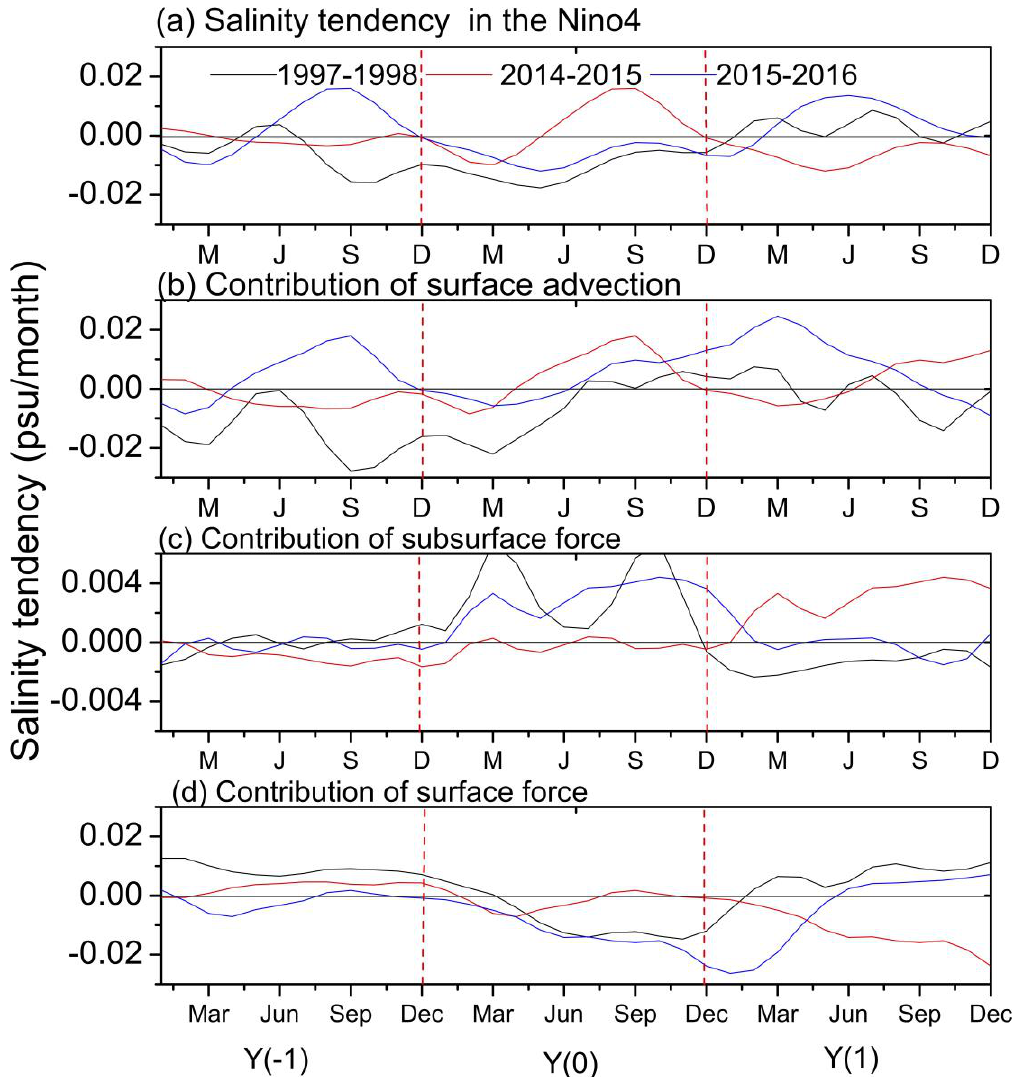
Figure 7. Contribution of MLS budget terms for ENs in 1997–1998 (black), 2014–2015 (red) and 2015–2016 (blue) for ( a ) salinity tendency, and salinity budget terms, ( b ) surface advection, ( c ) subsurface force, and ( d ) surface force in Niño 4 box. The horizontal black line represents zero. The units for budget terms are psu/day.